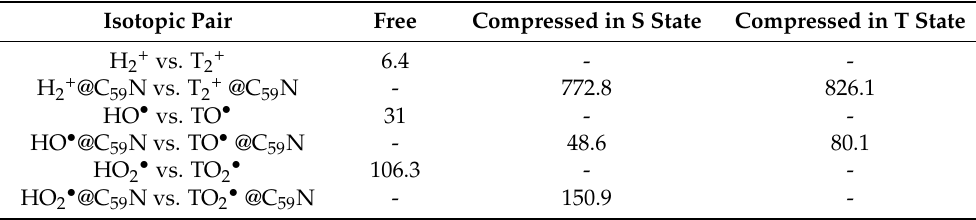
Table 3. Tritium isotope effects on free and compressed molecules. Isotopic Pair Free Compressed in S